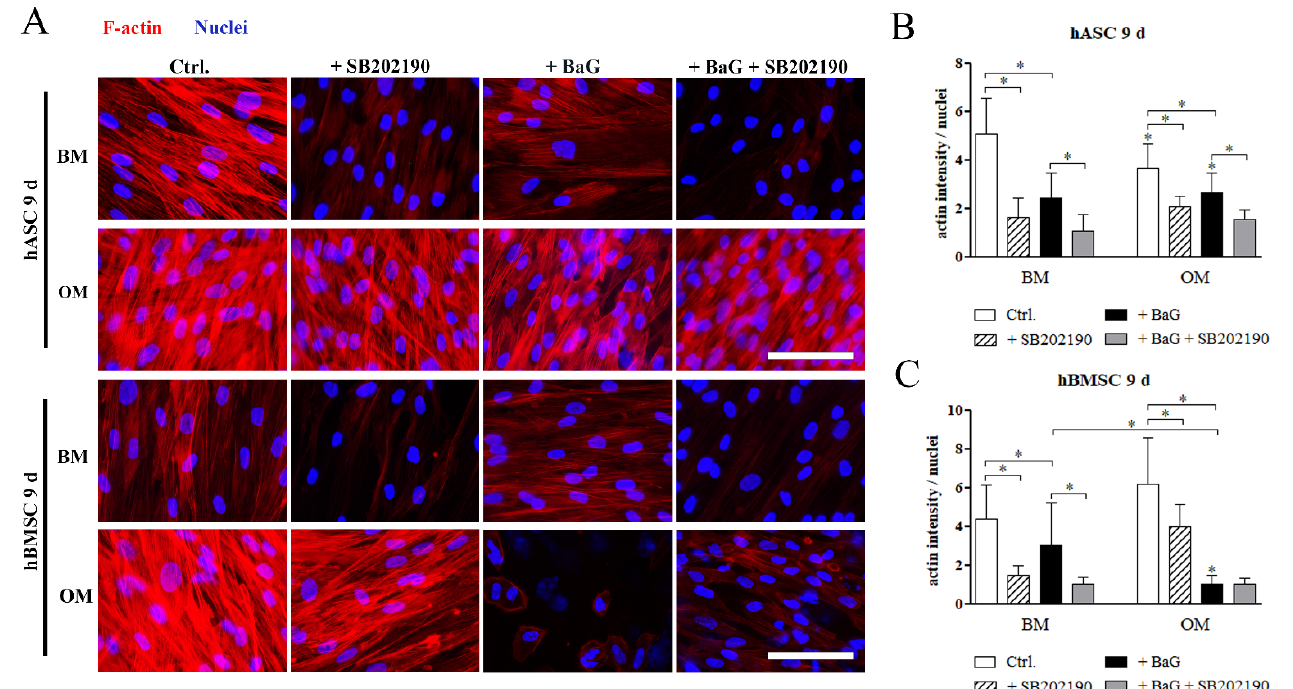
Figure 6. Actin cytoskeleton and F-actin intensity of hASCs and hBMSCs. ( A ) Representative Phalloidin-TRITC stained hASCs and hBMSCs cultured 9 days in BM, BaG BM, OM, and BaG OM supplemented with 3 µ M SB202190 inhibitor. The cells were imaged with a fluorescence microscope using constant exposure times with Alexa 546 for actin (red) and DAPI (blue) filters, and a 40× magnification. Scale bar is 100 μ m, and is used in every image. ( B , C ) Image ‐ based quantification of mean grey values of Phalloidin ‐ TRITC stained hASCs and hBMSCs normalized with nuclei count. Statistical analysis: hASCs: N = 16–18 images, 4 independent biological replicates of 2 donors; hBMSCs: N = 15–18 images, 4 independent biological replicates of 2 donors. *p ˂ 0.05. The asterisk above the error bar indicates the statistical difference compared to the BM control, and other comparisons are indicated with lines. Abbreviations: basic medium, BM; osteogenic medium, OM; and bioactive glass, BaG.